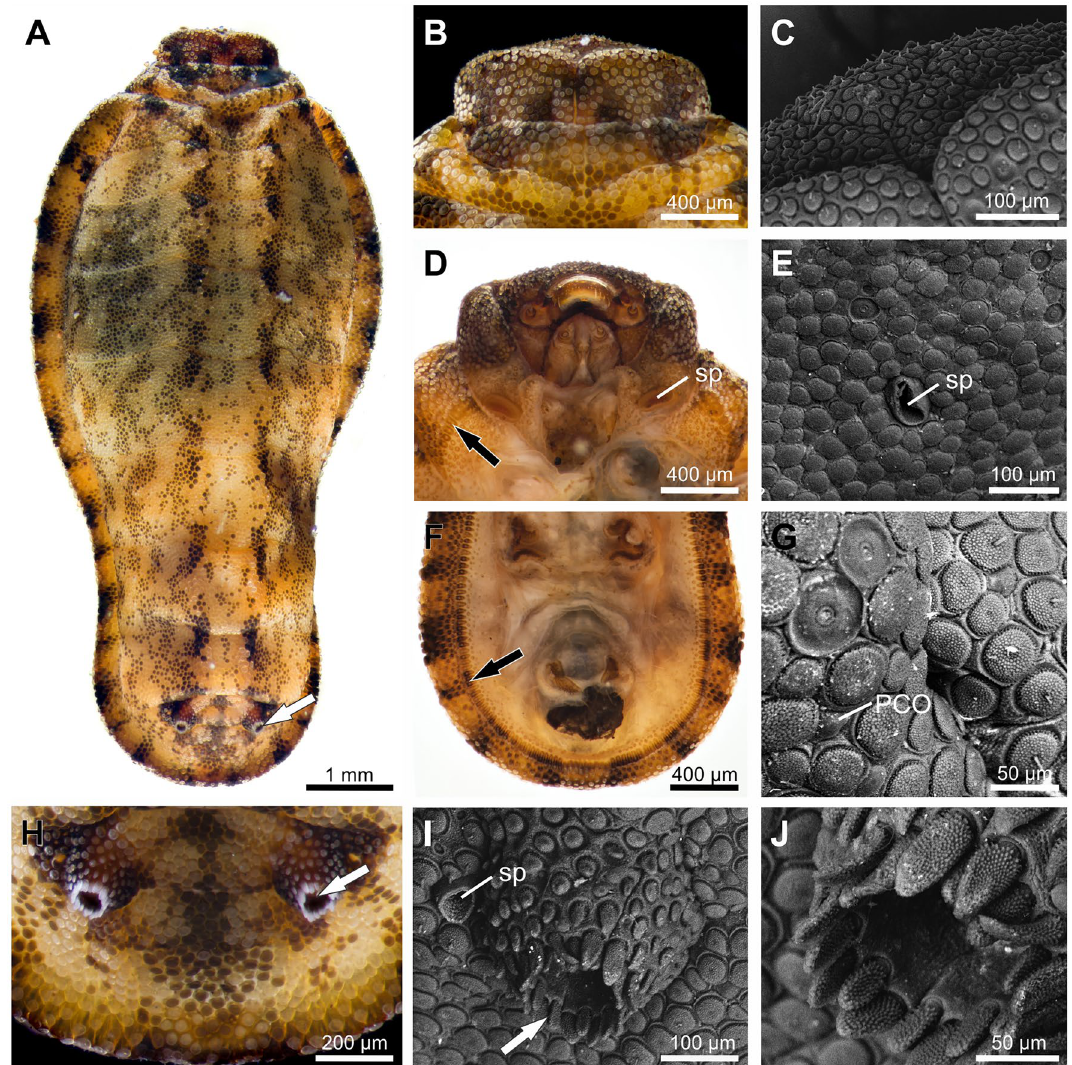
Figure 3. Morphology of the Pseudonymphidia agave caterpillar and details in scanning electron microscopy (SEM). ( A ) Dorsal view, the arrow indicates the openings of the tentacle nectary organs (TNOs) on the A8 abdominal segment. ( B ) Bilobed prothoracic shield in dorsal view. ( C ) SEM of the bilobed prothoracic shield. ( D ) Ventral view of the head and thoracic segments, showing the prothoracic spiracle (sp) and fringe of setae (black arrow). ( E ) SEM of the spiracle (sp) on the A3 abdominal segment. ( F ) Ventral view of the last abdominal segments; note lateral fringe of setae (black arrow). ( G ) SEM of the integument covered dorsally by arborescent flat setae and perforated cupola organs (PCO). ( H ) Opening of TNO (arrow); I) and J) SEMs of the opening of TNO (arrow), showing spiracle (sp) and elongated arborescent setae. Photos: ( A , B , D , F , H ) H. Bahena Basave; ( C , E , G , I , J ) M.